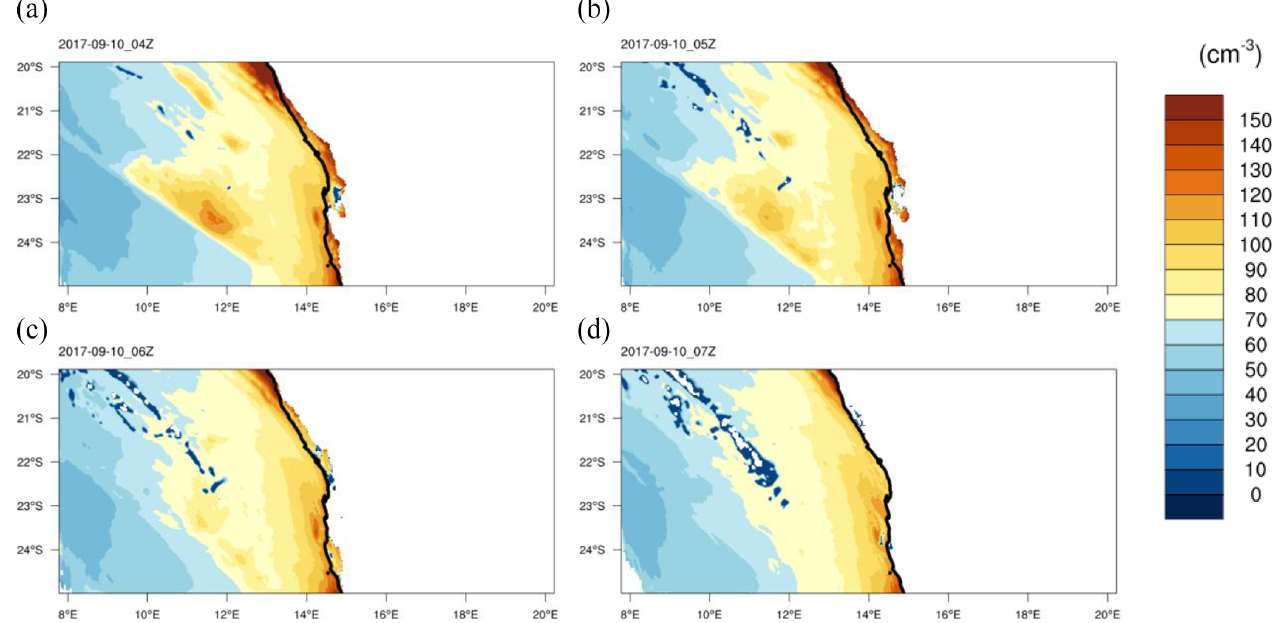
Figure 16. Cloud droplet concentration (cm − 3 ) during maximum extent and highest concentration for the event on 10 September 2017 for scenario CCN_C10. Maximum extent was at (a) 04:00UTC and maximum concentration at Henties Bay was at (d) 07:00UTC. The black dot is Henties